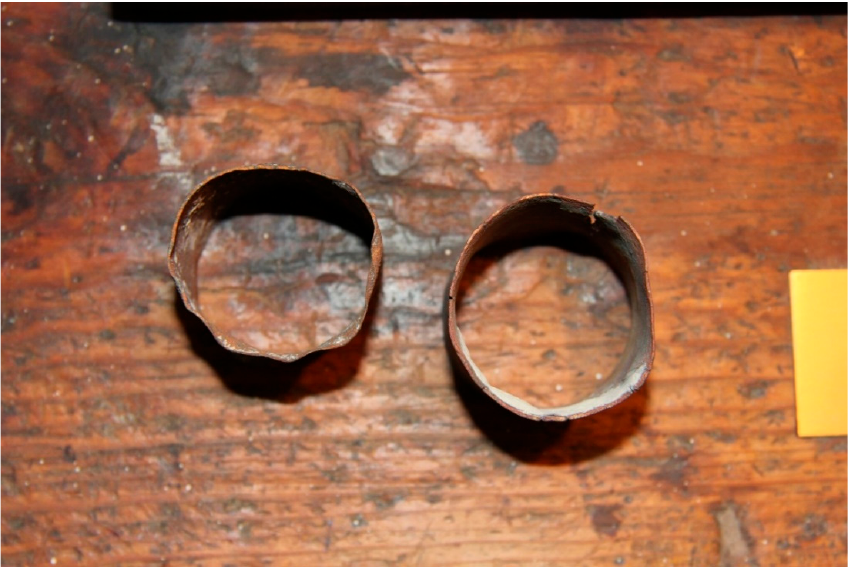
Figure 1. Casting Cylinders. Source: Dental Museum. Faculty of Dentistry. University of Granada (2021).